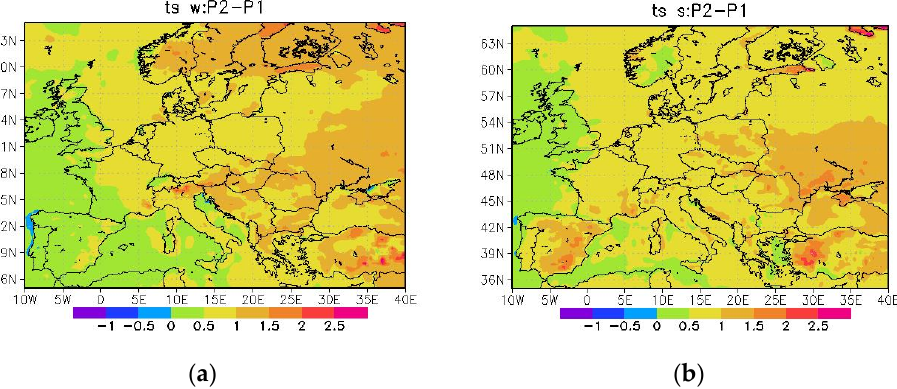
Figure 14. Total precipitation difference (P2–P1) (shade) for winter ( a ) and summer ( b ).